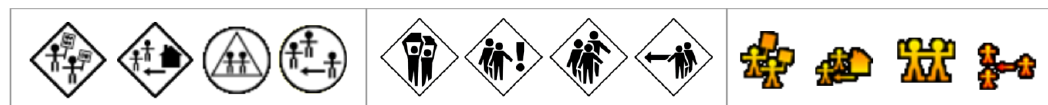
Figure 7. Different levels of visual complexity of cartographic symbols within the analysed sets.